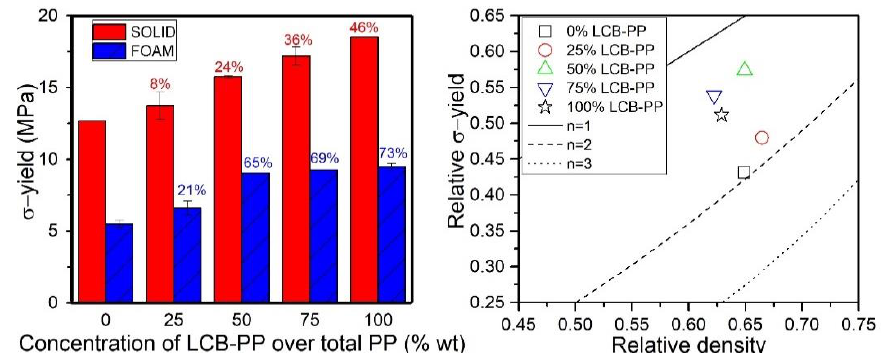
Figure 7. Stress at yield of solids samples and foams ( left ) and relative stress at yield of foams in the scale model representation ( right ). The percentages in the left graph indicate the percentage of improvement with respect to the 0% LCB-PP compound value, for solids ( red ) and foams ( blue ).